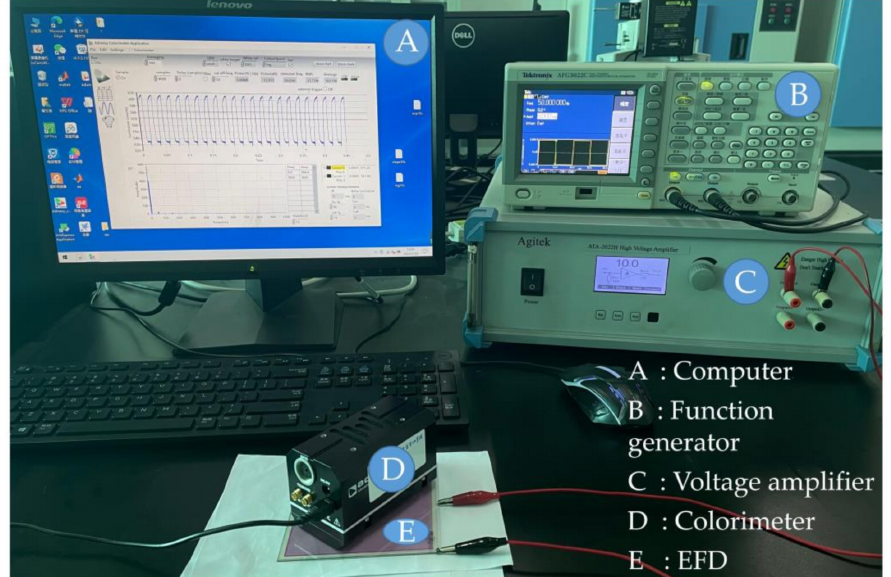
Figure 6. A performance verification platform for driving waveforms. It consisted of a colorimeter, an EFD, a computer, a function generator and a voltage amplifier. The computer, the function generator and the voltage amplifier were responsible for designing, amplifying and outputting the driving waveform. Next, the luminance change of EFDs was collected by the colorimeter. Then, the calculation of luminance was completed by the